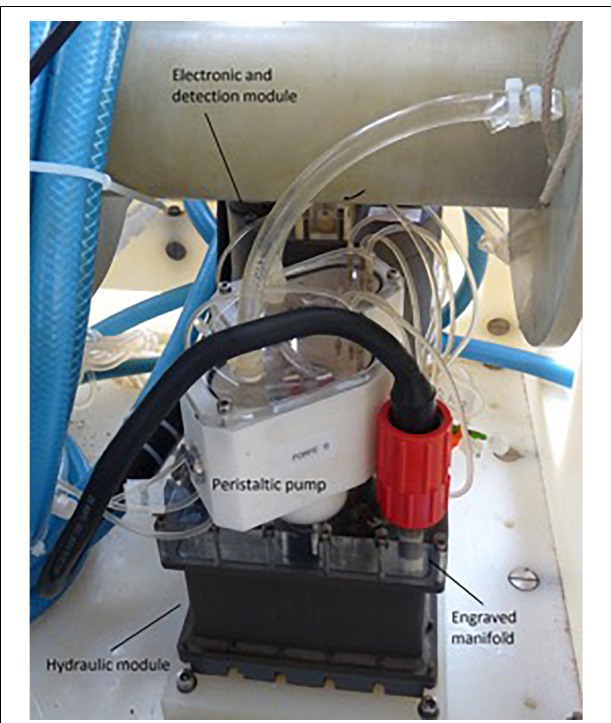
FIGURE 2 | The CHEmical MINIaturized analyzer (CHEMINI) for iron determinations in the vicinity of hydrothermal vents implemented on the EMSO-Azores MoMAR observatory infrastructure at 1700 m depth, hydraulic module: 240 ∗ 150 mm, electronic module: 140 ∗ 264 mm (Laës-Huon et al.,